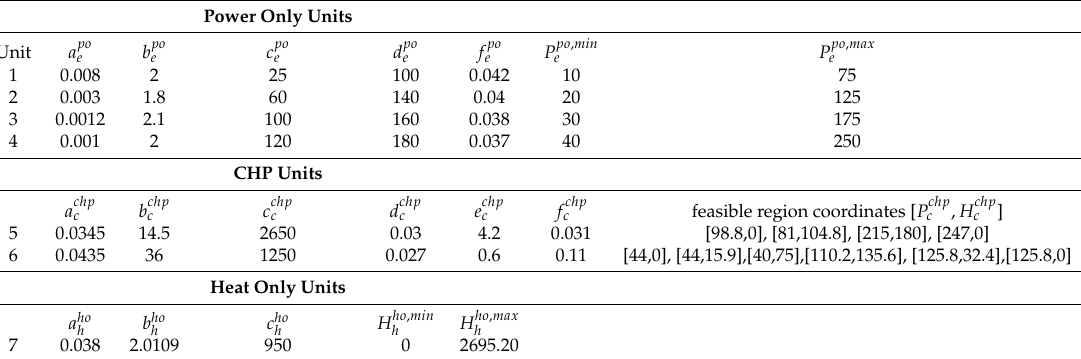
Table 6. Cost function parameters of test system